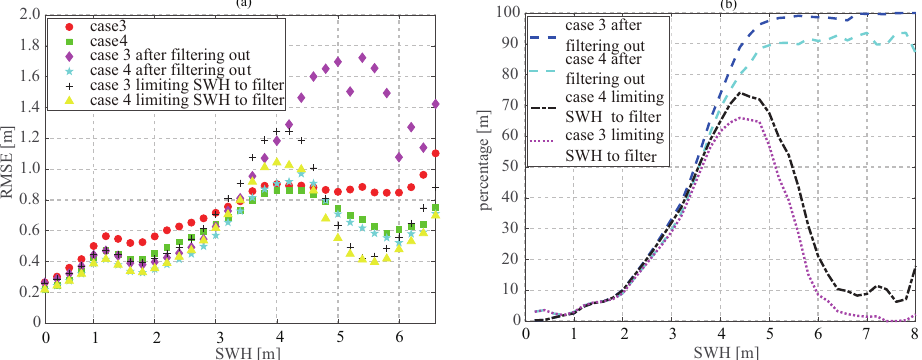
Figure 16. ( a ) Ratios and ( b ) RMSEs of outliers by means of a neural network filter for different SWHs.